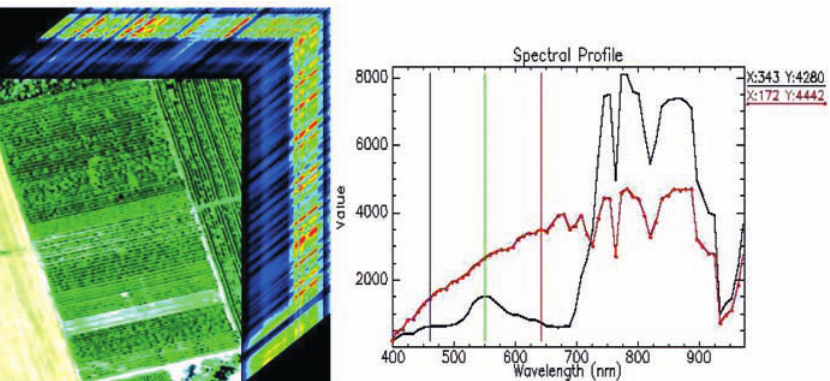
Figure 4. The 3D data cube made from 69 VIS-NIR channels and spectral reflectance curves of